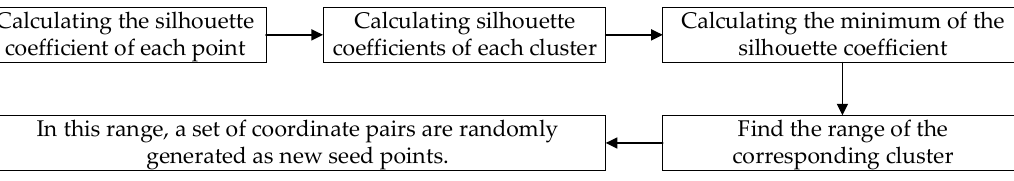
Figure 5. New seed point selection process.